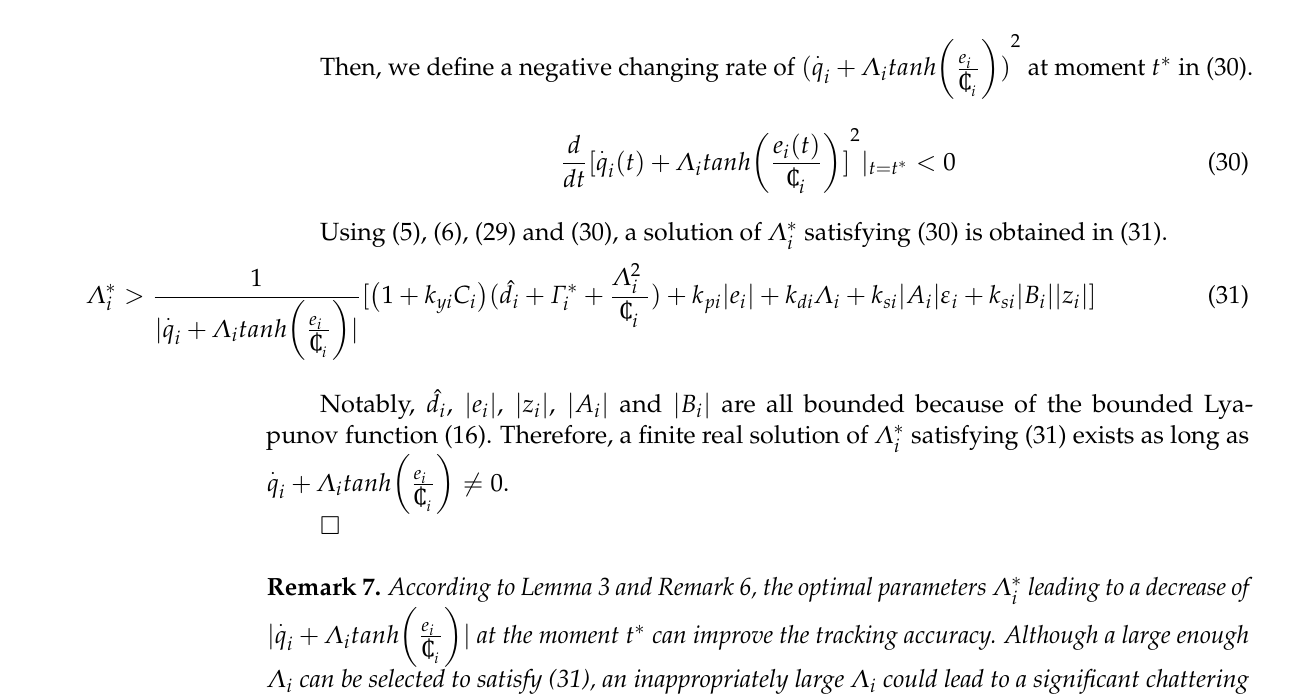
Figure 2. Membership function of fuzzy input of the 𝑖 (cid:3047)(cid:3035) subsystem. The parameters of membership function shown in Figure 2 are defined as follows: 𝐿𝑖𝑛(𝑒 (cid:3036) ) = (cid:4676)𝜁 (cid:2869),(cid:2869)((cid:3036)) , … , 𝜁 (cid:2869),𝒶((cid:3036)) , … , 𝜁 (cid:2869),𝒜((cid:3036)) (cid:4677), 𝒶 = 1,2, … , 𝒜 (33) 𝐿𝑖𝑛(𝑞(cid:4662) (cid:3036) ) = (cid:4676)𝜁 (cid:2870),(cid:2869)((cid:3036)) , … , 𝜁 (cid:2870),𝒷((cid:3036)) , … , 𝜁 (cid:2870),ℬ((cid:3036)) (cid:4677), 𝒷 = 1,2, … , ℬ (34) where 𝒜 is the number of fuzzy sets ( 𝜁 (cid:2869),𝒶 ) for the fuzzy input 𝑒 (cid:3036) , and ℬ is the number of fuzzy sets ( 𝜁 (cid:2869),𝒷 ) for the fuzzy input 𝑞(cid:4662) (cid:3036) . The 𝓃 -th fuzzy rule in fuzzy Q learning is defined as follows: 𝑅 𝓃,(cid:3036) : IF 𝓈 (cid:2869),(cid:3036)(𝕜) is 𝐿 (cid:2869),(cid:3036)(𝕜) and 𝓈 (cid:2870),(cid:3036)(𝕜) is 𝐿 (cid:2870),(cid:3036)(𝓃) and …… and 𝓈 𝓂,(cid:3036)(𝕜) is 𝐿 𝓂,(cid:3036)(𝓃) , THEN 𝔲 (cid:3036)(𝓃) ∈ 𝔘 (cid:3036),𝓃 that 𝔲 (cid:3036)(𝓃) = 𝔲 (cid:3036),(cid:2869)(𝓃) with 𝓆 (cid:3036)((cid:3038)) (𝓃, 1) or 𝔲 (cid:3036)(𝓃) = 𝔲 (cid:3036),(cid:2870)(𝓃) with 𝓆 (cid:3036)((cid:3038)) (𝓃, 2) or 𝔲 (cid:3036)(𝓃) = 𝔲 (cid:3036),(cid:2871)(𝓃) with 𝓆 (cid:3036)((cid:3038)) (𝓃, 3) ,…., 𝔲 (cid:3036)(𝓃) = 𝔲 (cid:3036),(cid:3043)(𝓃) with 𝓆 (cid:3036)((cid:3038)) (𝓃, 𝑝) ,…., 𝔲 (cid:3036)(𝓃) = 𝔲 (cid:3036),(cid:3017)(𝓃) . with 𝓆 (cid:3036)((cid:3038)) (𝓃, 𝑃)